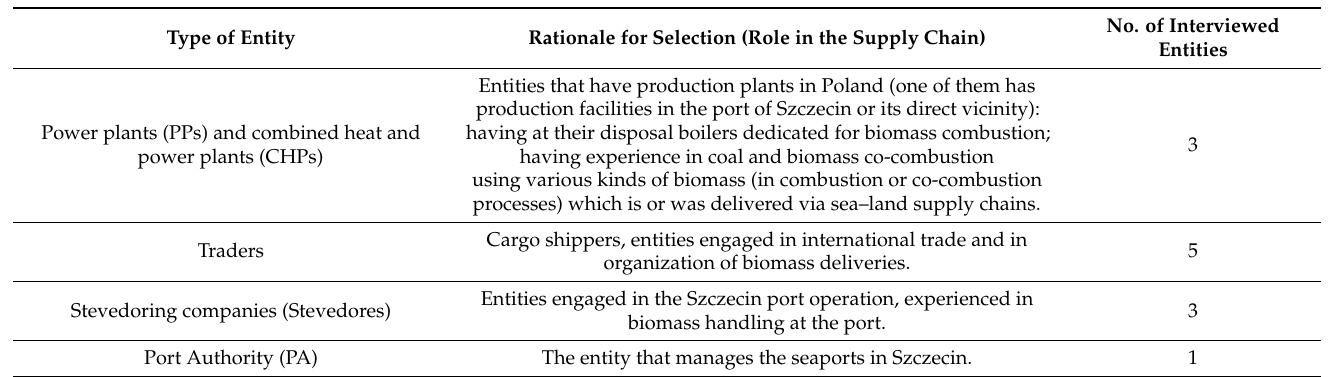
Table 1. Characteristics of the interviewed